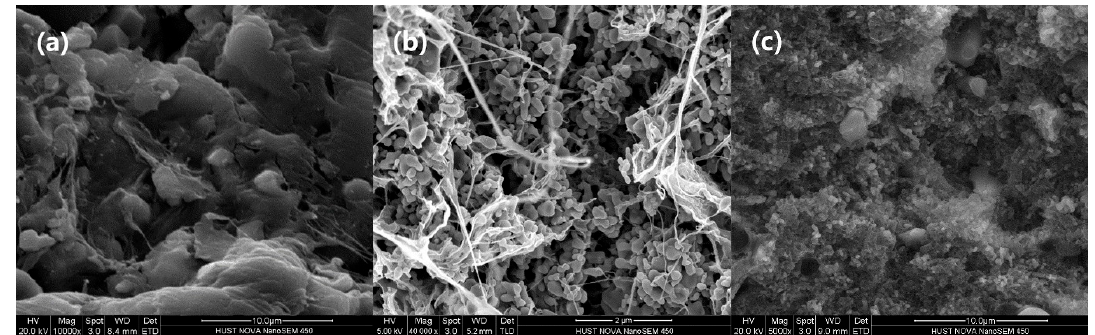
Figure 5. SEM micrograph of the PTFE-based composite filled by different CCTO particle sizes: ( a ) micron CCTO filling; ( b ) submicron CCTO filling; and ( c ) micron/submicron co-blending CCTO filling.